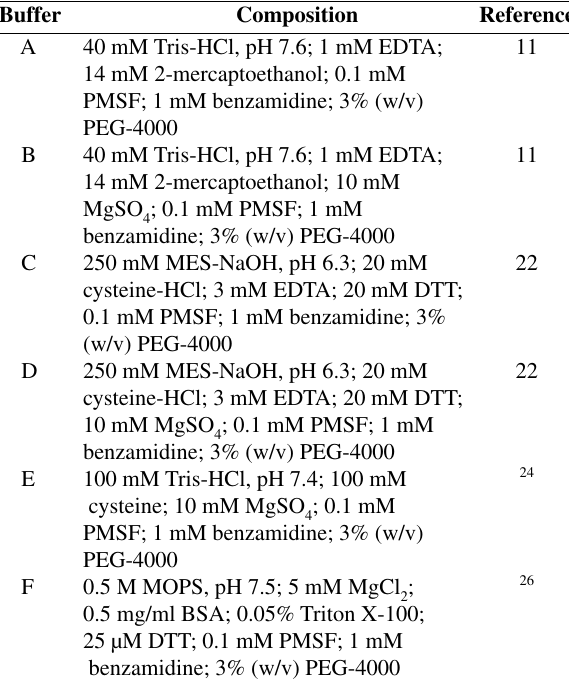
Table 2 . Extraction buffers tested for enzyme assays, modified from the indicated references.